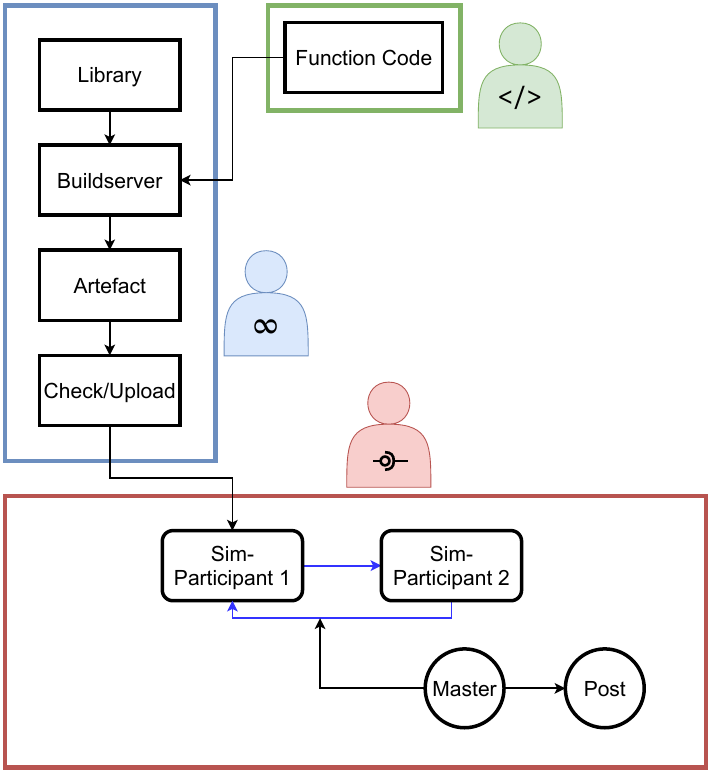
Figure 1. Schematics of a simple build and simulation